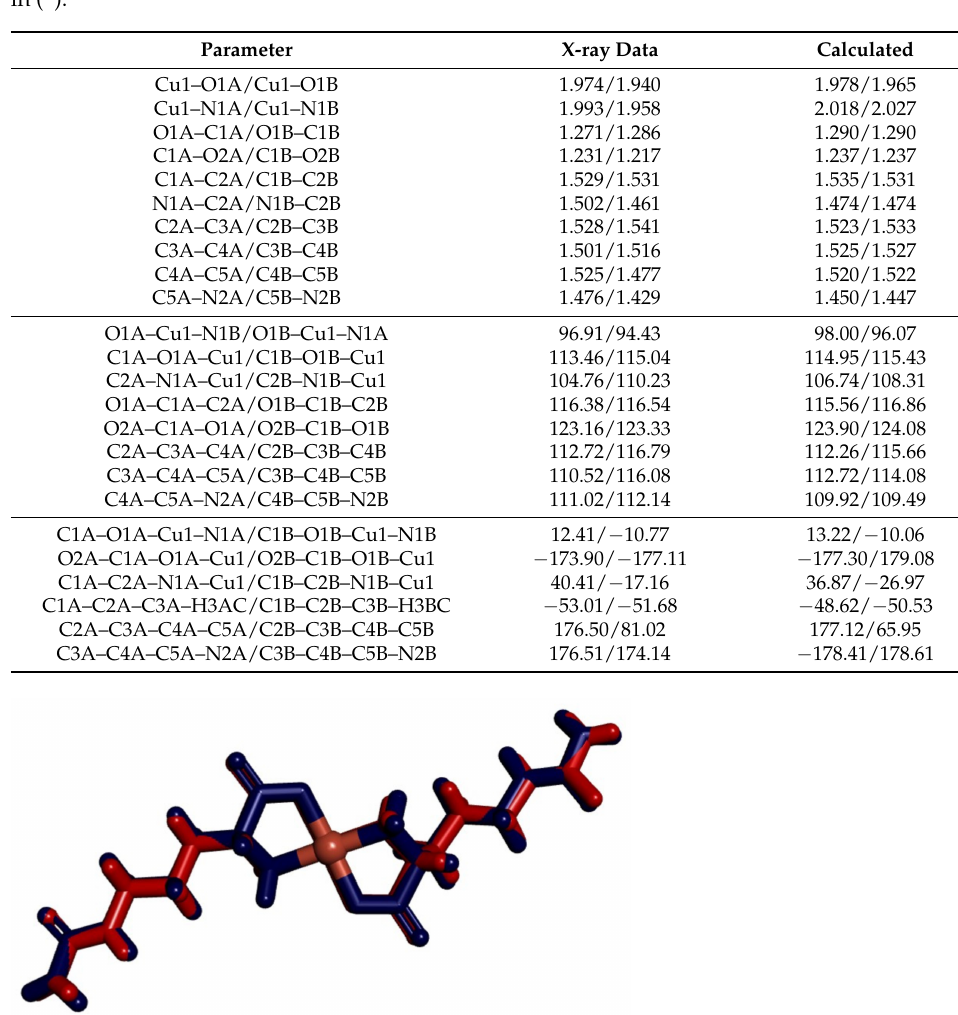
Table 3. Selected X-ray and optimized parameters for the compound [Cu(Citr) 2 ] obtained at the level of theory mPW1PW91/6-31G(d)-LANL2DZ and ECP=LANL2DZ. Bond lengths in (Å) and angles in ( ◦ ).